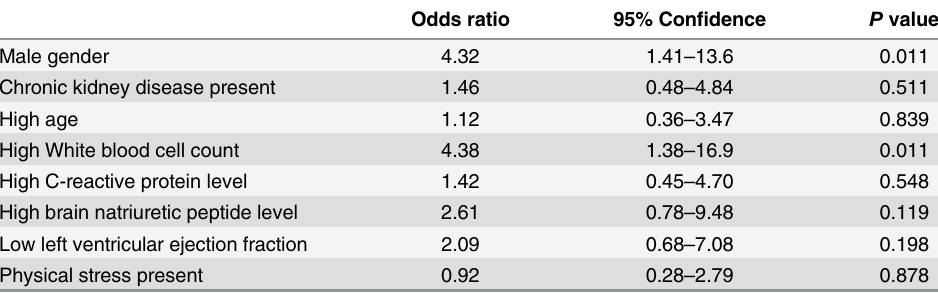
Table 4. Stepwise multiple logistic regression